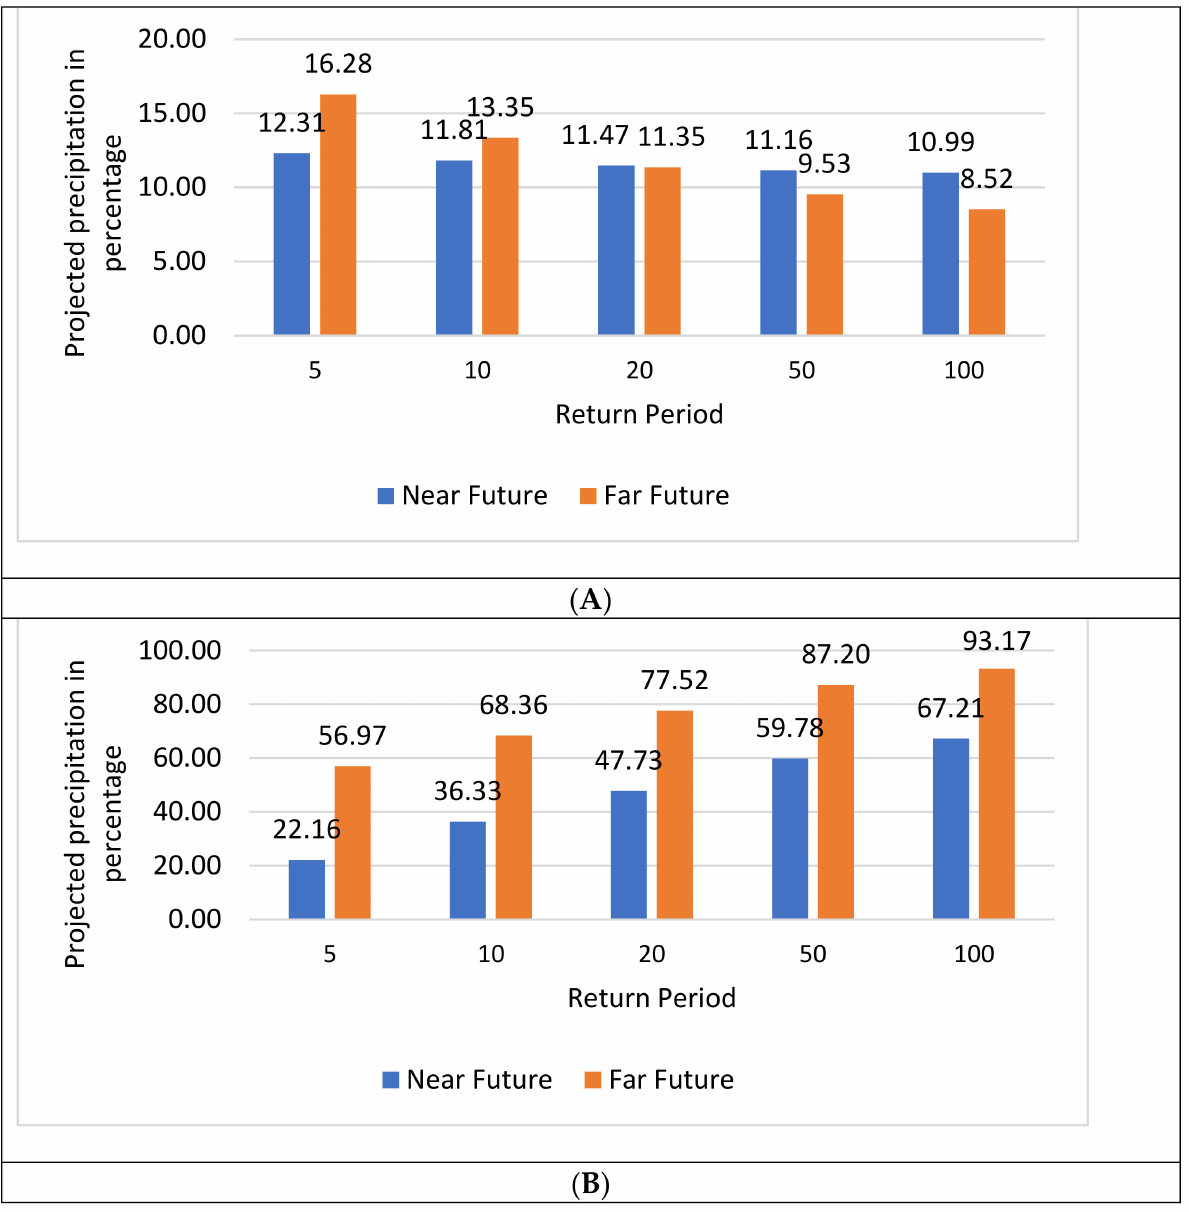
Figure 9. The projected 3-day extreme precipitation percentage ( A ) from the BCC-CSM2-MR model and ( B ) from the MRI-ESM2-0